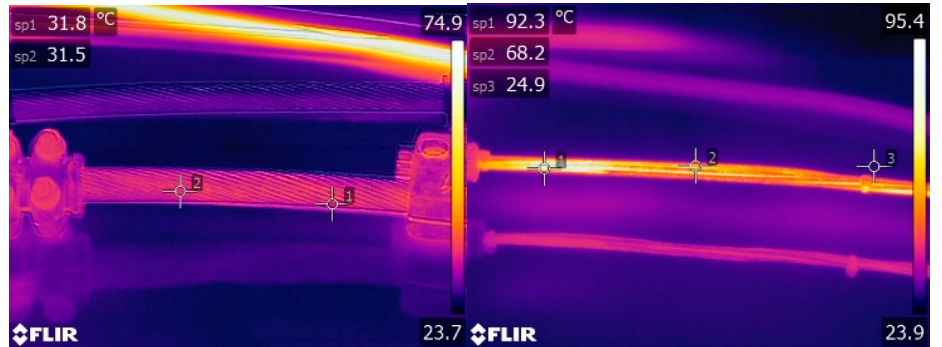
Figure 11. Camera measured temperature at parallel binding.